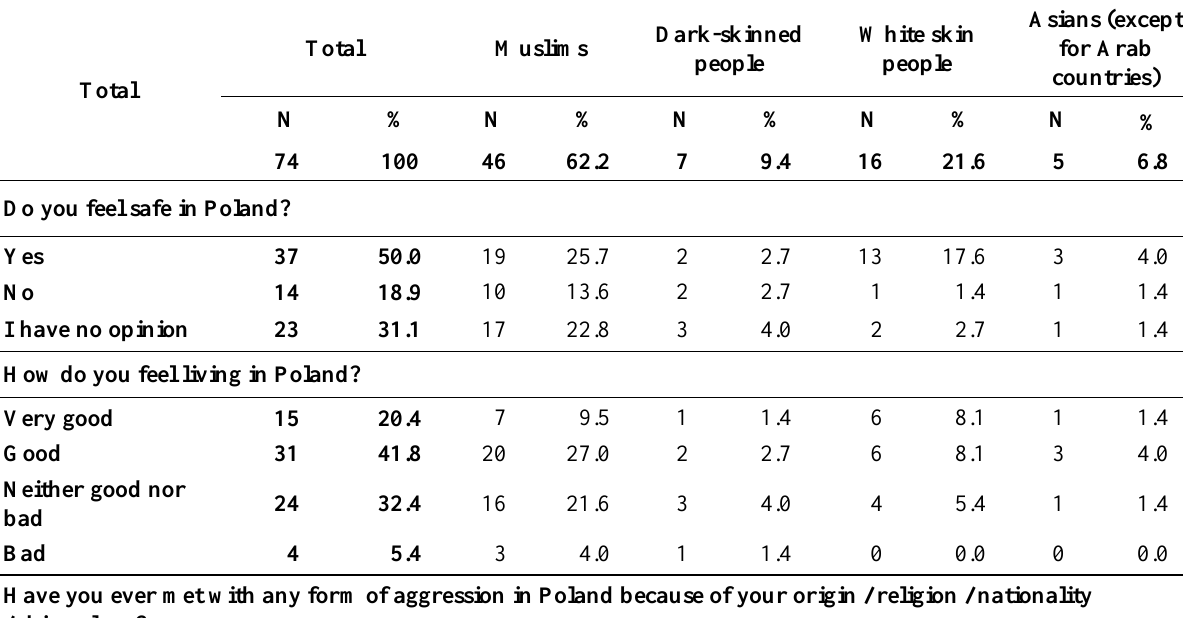
Asians (except Dark-skinned White skin for Arab people people countries)